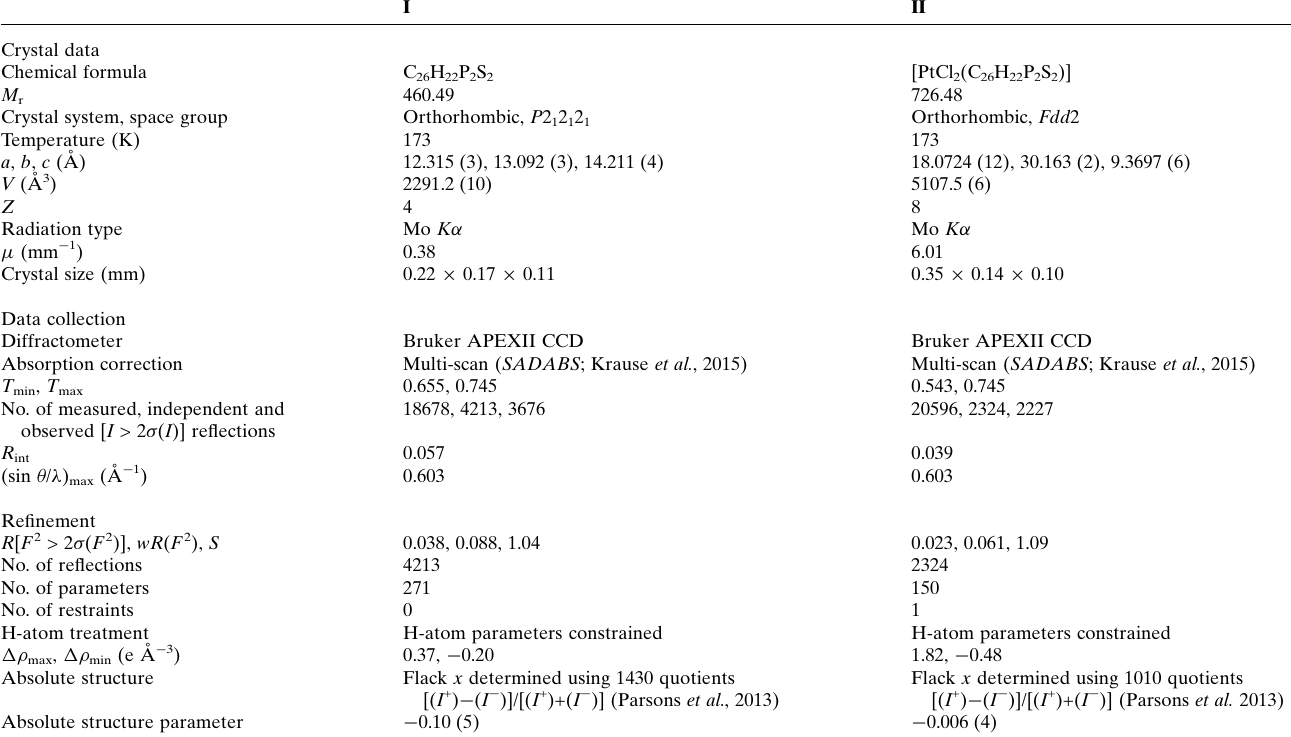
Table 3 Experimental